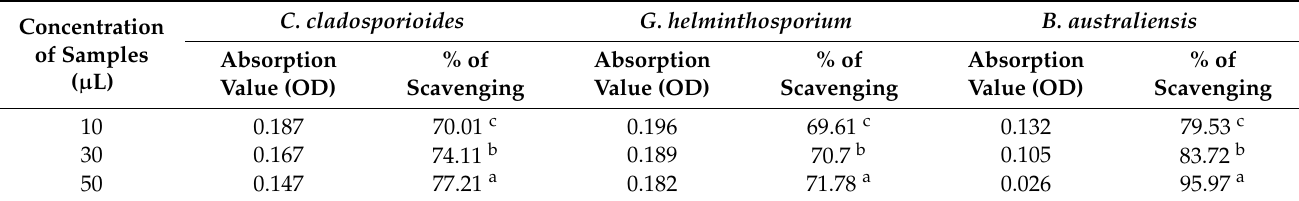
Table 5. DPPH antioxidant scavenging activity of the intracellular extract of Cladosporium cladospori- oides, Graminicolous helminthosporium , and Bipolaris australiensis . Data are represented as means ± SD of three replicates. Numbers within a column followed by the same letters are not significantly different according to Duncan’s multiple range test at p ≤ 0.05.